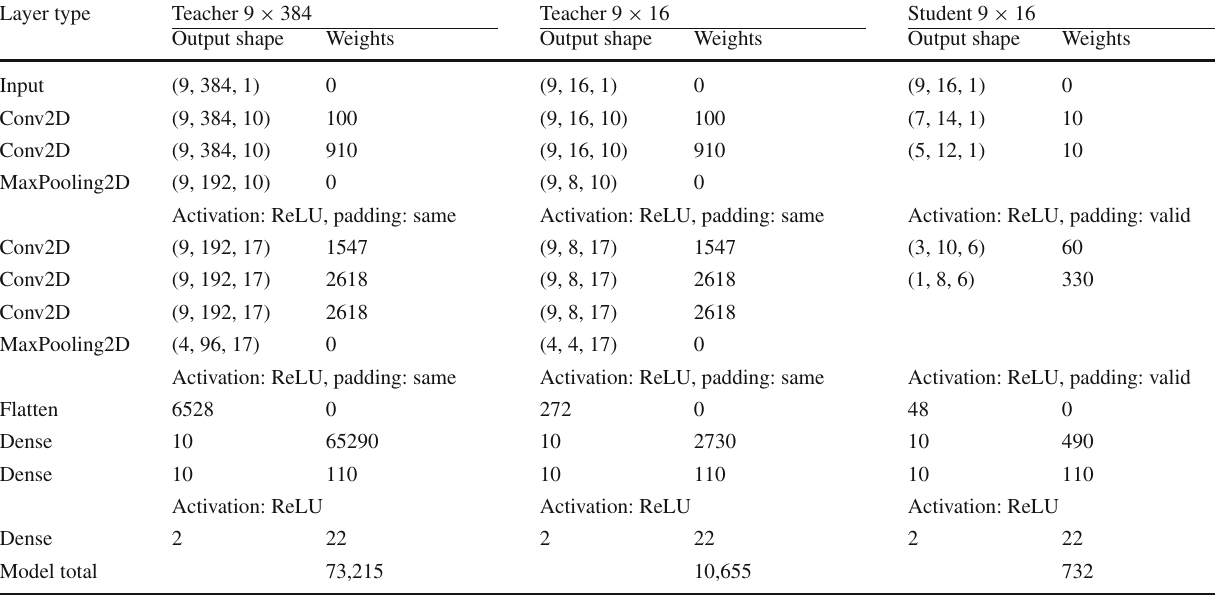
Table 1 Specifics of the CNN models used for the Teacher with input image size of 9 × 384 and for the Teacher and the Student with 9 × 16 images. The numbers reported in the “output shape” column represent respectively the height, width and depth of the output of each layer Layer type